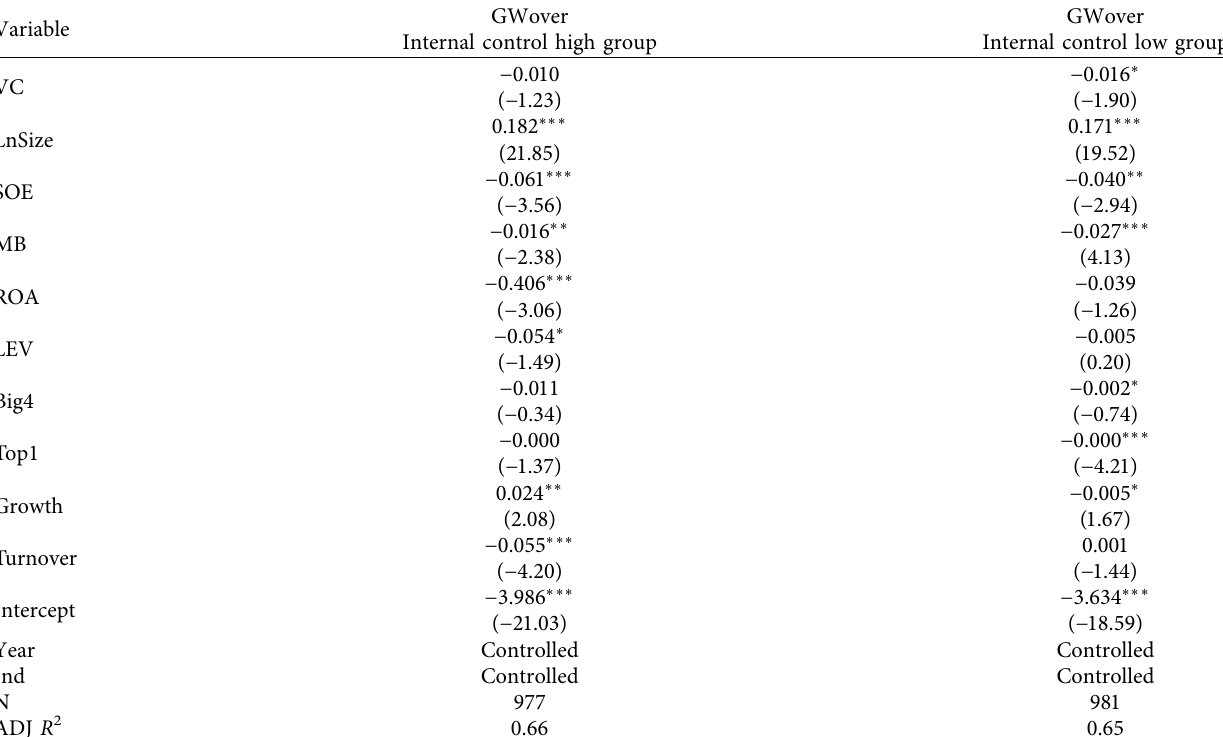
Table 14: Regression results of internal